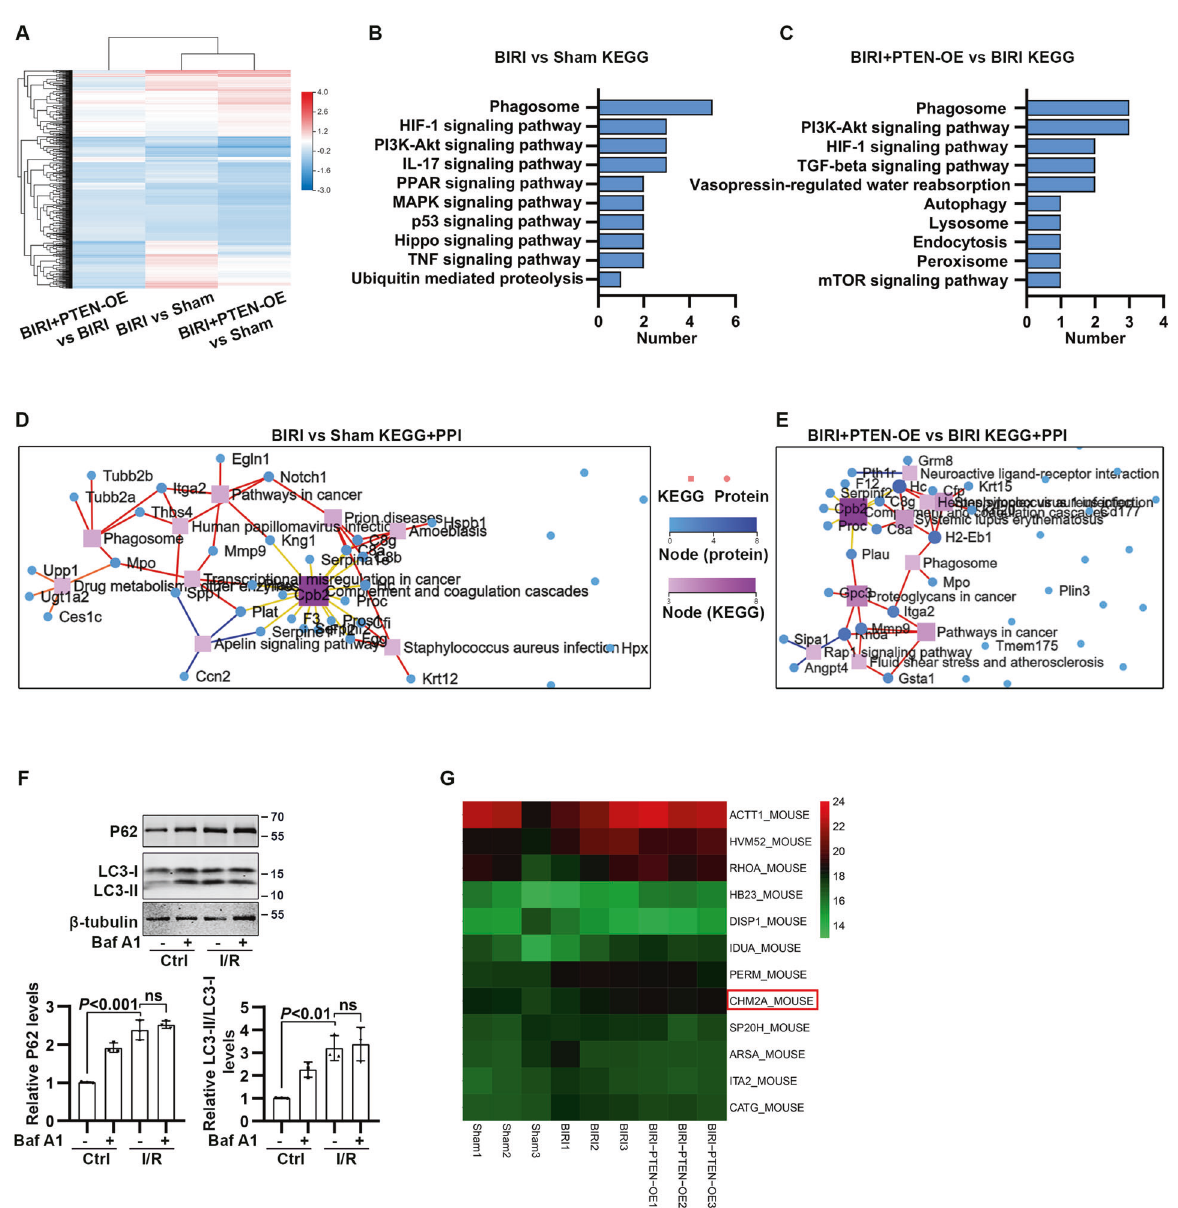
Fig. 5 Mass spectrometry-based proteomics in I/R-induced RPTC-speci fi c PTEN overexpression mice. A The heat map of renal distinct protein expression comparing sham, BIRI, and BIRI + PTEN-OE mice ( n = 3 mice in each group). B , C The Kyoto Encyclopedia of Genes and Genomes (KEGG) pathway enrichment of differentially expressed proteins (DEPs) comparing BIRI versus sham and BIRI + PTEN-OE versus BIRI groups, respectively. D , E The KEGG pathway enrichment combined with protein – protein interaction (PPI) analysis of DEPs, comparing BIRI versus sham and BIRI + PTEN-OE versus BIRI groups, respectively. F Western blotting analysis showing changes in LC3 and P62 in I/R-treated HK-2 cells in the absence and presence of Baf A1. G The heat map of DEPs enriched in the phagosome, endocytosis, autophagy, and lysosome pathways among sham, BIRI, and BIRI + PTEN-OE